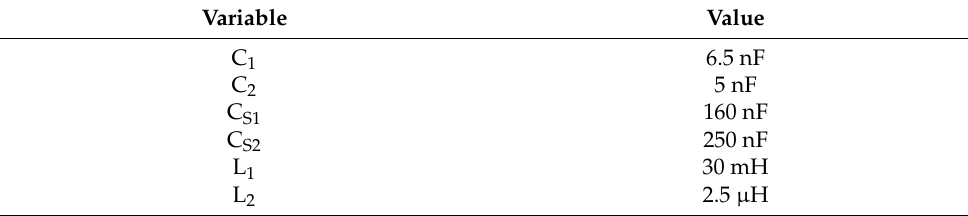
Table 2. Passive elements for generator